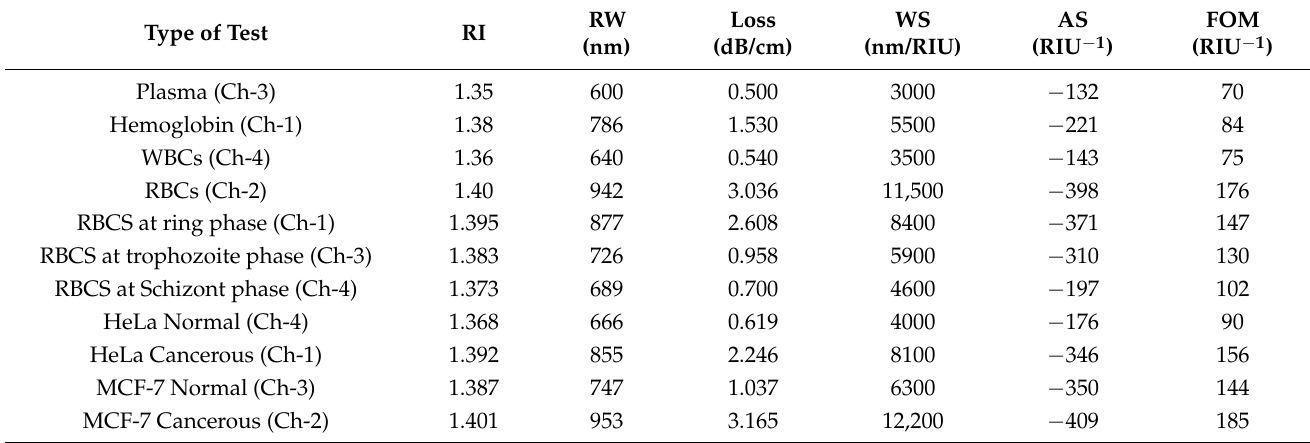
Table 3. Performance of the proposed multi-channel sensor in bioinformatics detection.